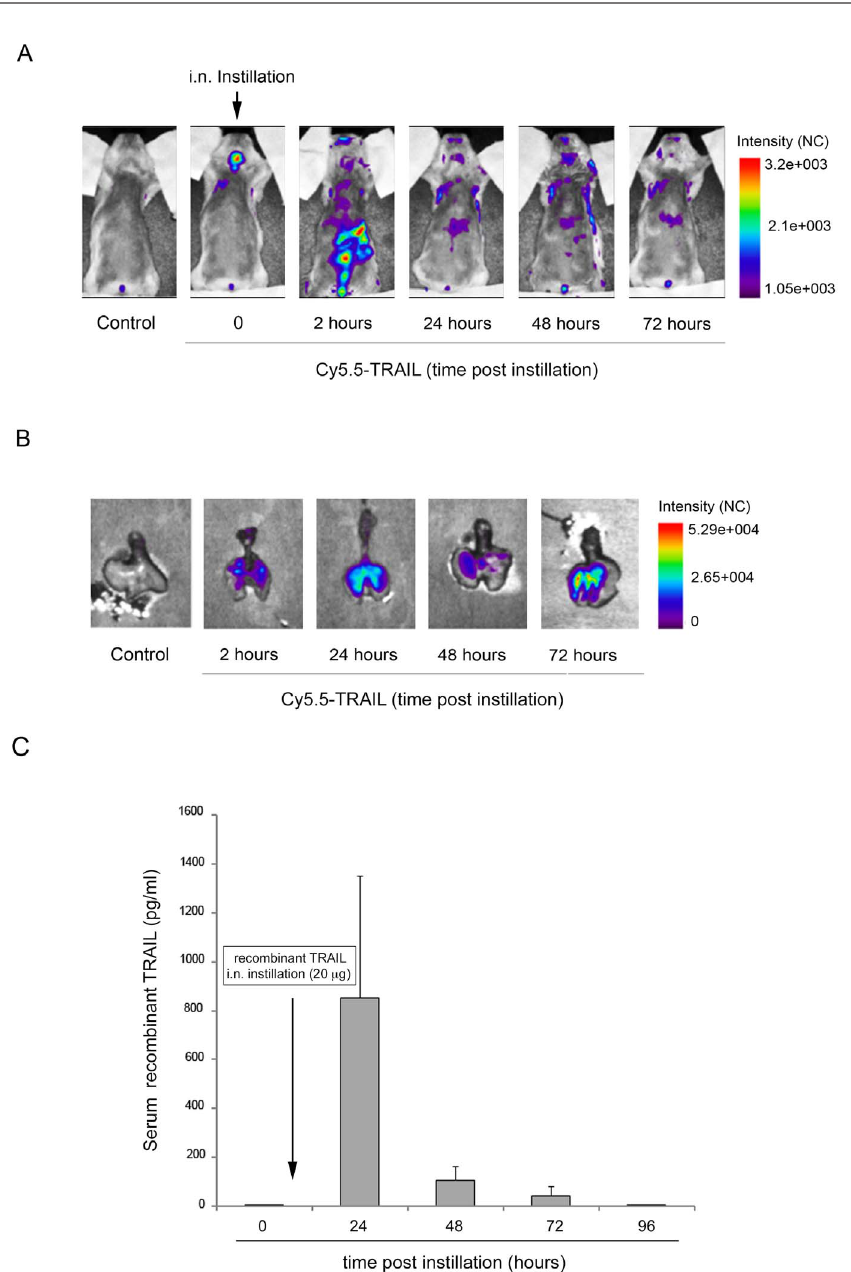
Fig. 1. In vivo biodistribution of recombinant TRAIL. Mice were i.n. instilled with recombinant TRAIL (20 m g). In A , the distribution of the labeled Cy5.5-TRAIL was recorded at the indicated time intervals by whole body scans in six mice. Results of one representative mouse before (control) and after i.n. instillation are shown. In B , ex vivo representative images of lungs isolated from mice sacrificed at the indicated time points after i.n. instillation of Cy5.5-TRAIL compared to a representative lung isolated from a control mouse (i.n. instillation with control vehicle). In C , after i.n. instillation a time course detection of circulating recombinant human TRAIL was assessed by ELISA performed on murine sera samples. Results are reported as mean ¡ SD of 6 mice.